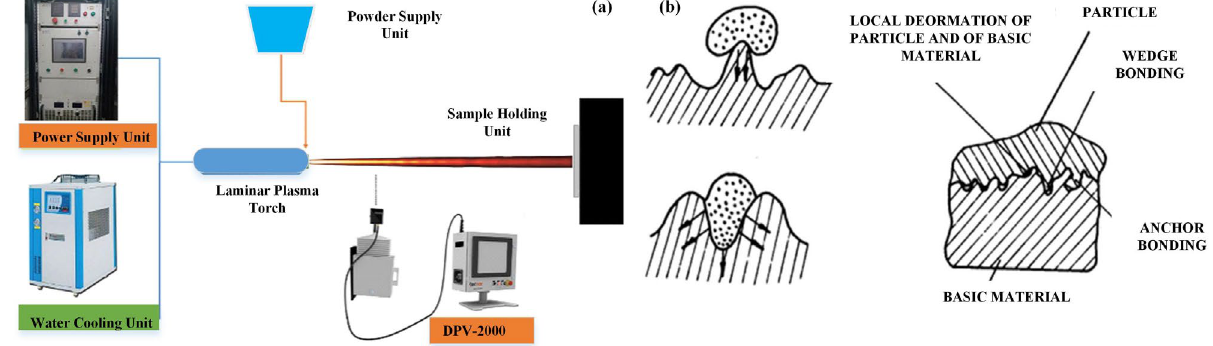
Figure 1. Plasma spraying technology: ( a ) schematic diagram of plasma spraying technology [58]; ( b ) deformation scheme of particles on rough substrate [60].